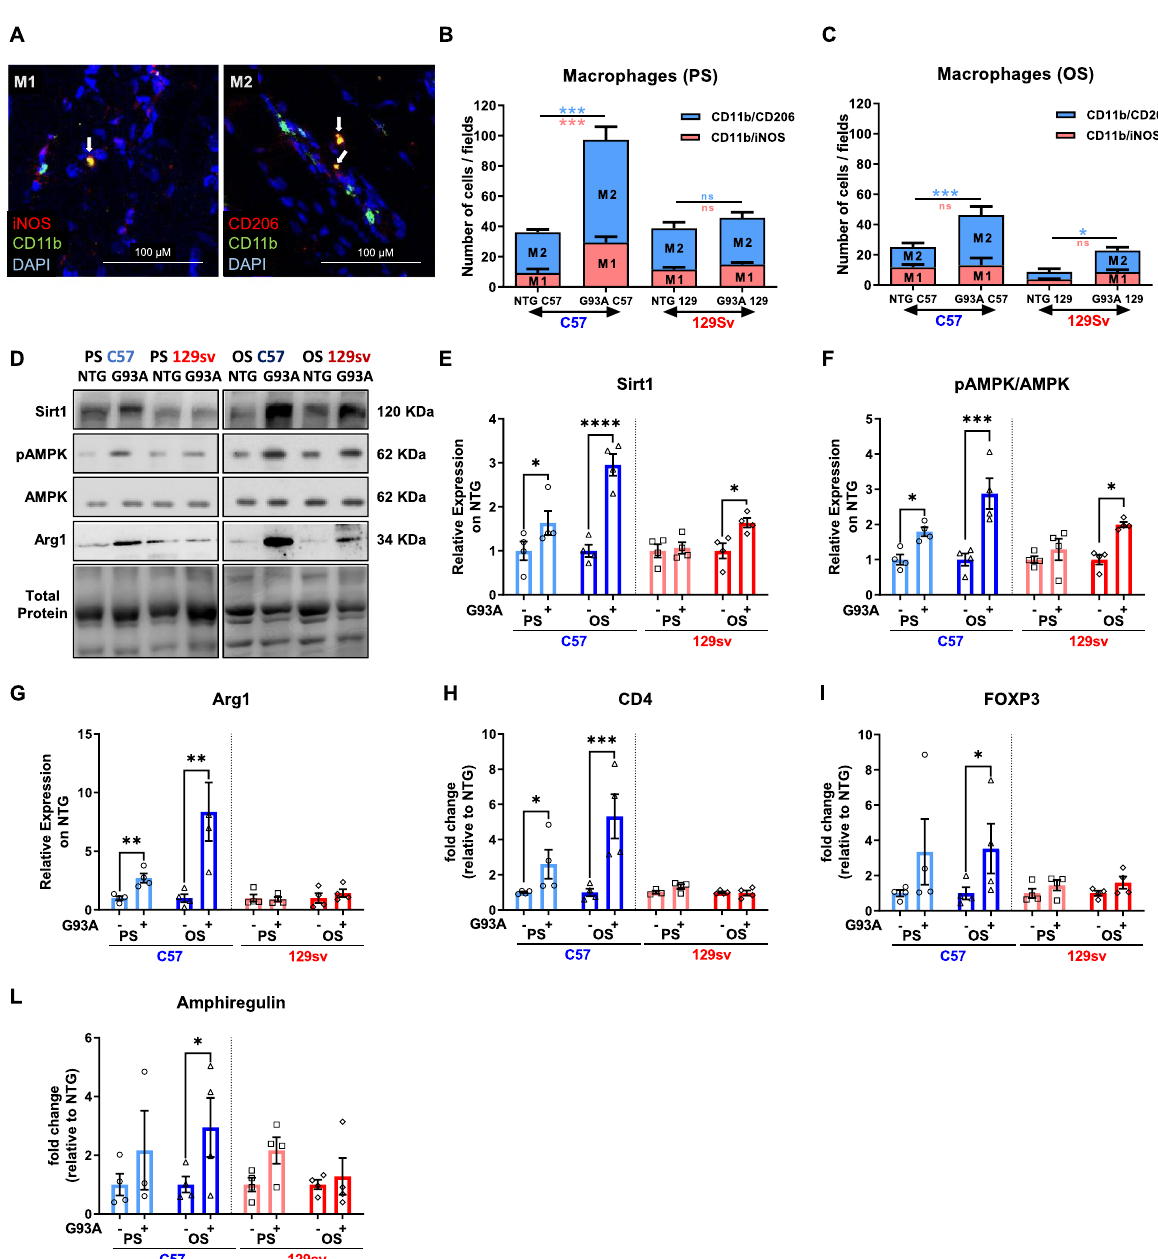
Fig. 7 The macrophage transition from M1- to M2-biased phenotype drives myogenesis in slow-progressing mice. A Representative confocal micrographs showing the immunostaining for M1 (iNOS /CD11b /DAPI ) and M2 (CD206 /CD11b /DAPI ) macrophages (MΦ) in longitudinal + + + + + + GCM sections of transgenic mice. B and C Percentage of M1 and M2 MΦ in the GCM of transgenic and NTG littermates at the presymptomatic (PS) ( B ) and onset (OS) ( C ) disease stages, calculated relative to the total number of CD11b /DAPI cells counted on five stereological 0.6 0.6 mm + + × fields analysed for each slice. Data are expressed as the mean SEM ( n 4). Significance was calculated with one-way ANOVA with uncorrected ± = Fisher’s LSD post-analysis (* p 0.05, *** p 0.001). D – F Representative immunoblot images (full blots images in Additional file 2) and relative ≤ ≤ densitometric analysis of D and E Sirt-1, D and F pAMPK/AMPK, D and F Arg1, and D and G protein expression in GCM muscles of C57SOD1 G93A and 129SvSOD1 G93A mice compared with NTG littermates ( n 4). Data are expressed as the mean ( SEM). Significance was calculated with 2-way = ± ANOVA with uncorrected Fisher’s LSD post-analysis (* p 0.05; **** p 0.0001). H – L Real-time qPCR for CD4 ( H ), FOXP3 ( I ), amphiregulin ( L ) mRNA ≤ ≤ transcripts in GCM muscle of C57SOD1 G93A and 129SvSOD1 G93A mice compared with NTG littermates ( n 4). Data are expressed as the mean = ( SEM)-fold change ratio between NTG C57 mice, C57SOD1 G93A mice, 129SvSOD1 G93A mice, and NTG 129Sv mice. Significance was calculated with ± 1-way ANOVA with uncorrected Fisher’s LSD post-analysis (* p 0.05, ** p ≤ ≤